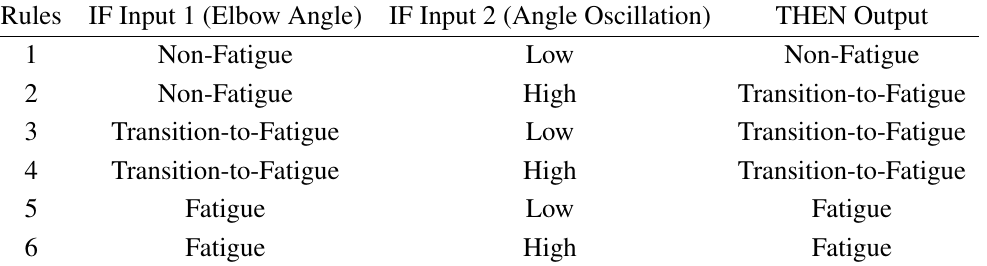
Table 5. Rule base for signal